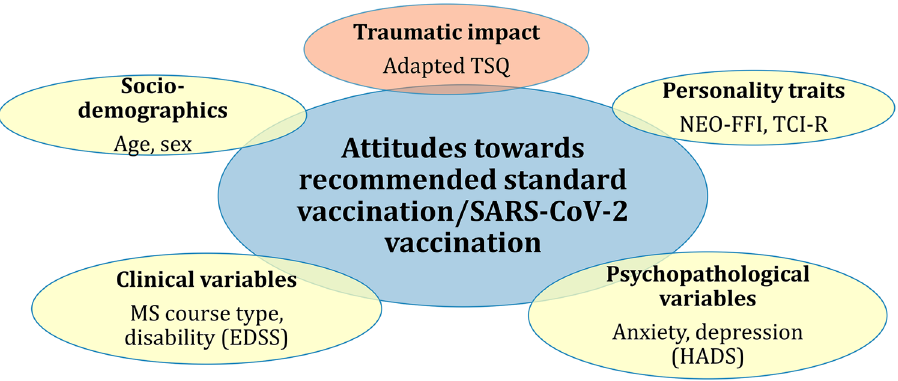
Figure 1. Variables to be analysed for associations with vaccination willingness in general and regarding SARS- CoV-2. EDSS Expanded Disability Status Scale, HADS Hospital Anxiety and Depression Scale, MS Multiple sclerosis, NEO-FFI NEO Five Factor Inventory; TCI-R Temperament and Character Inventory Revised, TSQ Trauma Screening